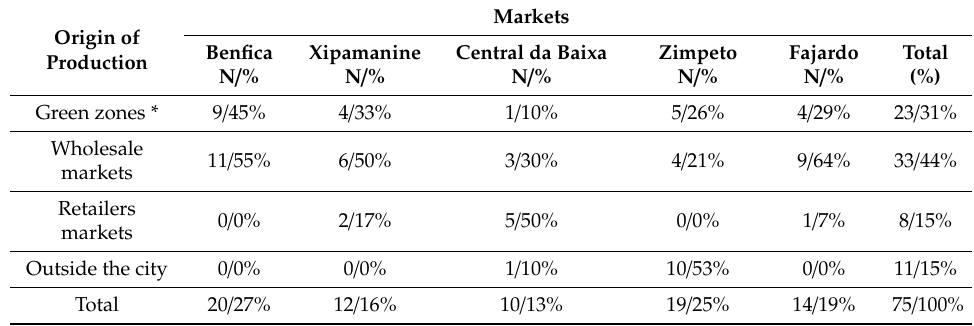
Table 2. Origin of production and supply chain of horticultural products in the five markets studied. Origin of Production Origin of